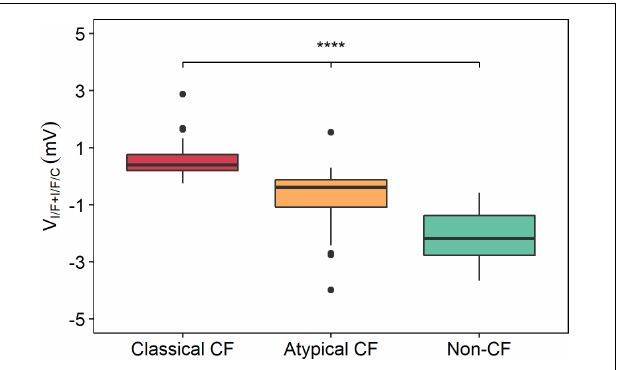
FIGURE 2 | Distribution of V I / F + I / F / C values between the three groups of individuals with distinct levels of disease severity. The V I / F + I / F / C values were plotted for each group of individuals with distinct levels of disease severity, showing that the most severe disease state (classical CF) had higher V I / F + I / F / C values, the atypical forms of CF had intermediate V I / F + I / F / C values and non-CF controls had lower V I / F + I / F / C values. Significant differences were found between these three groups by a Kruskal–Wallis rank sum test. (**** p ≤